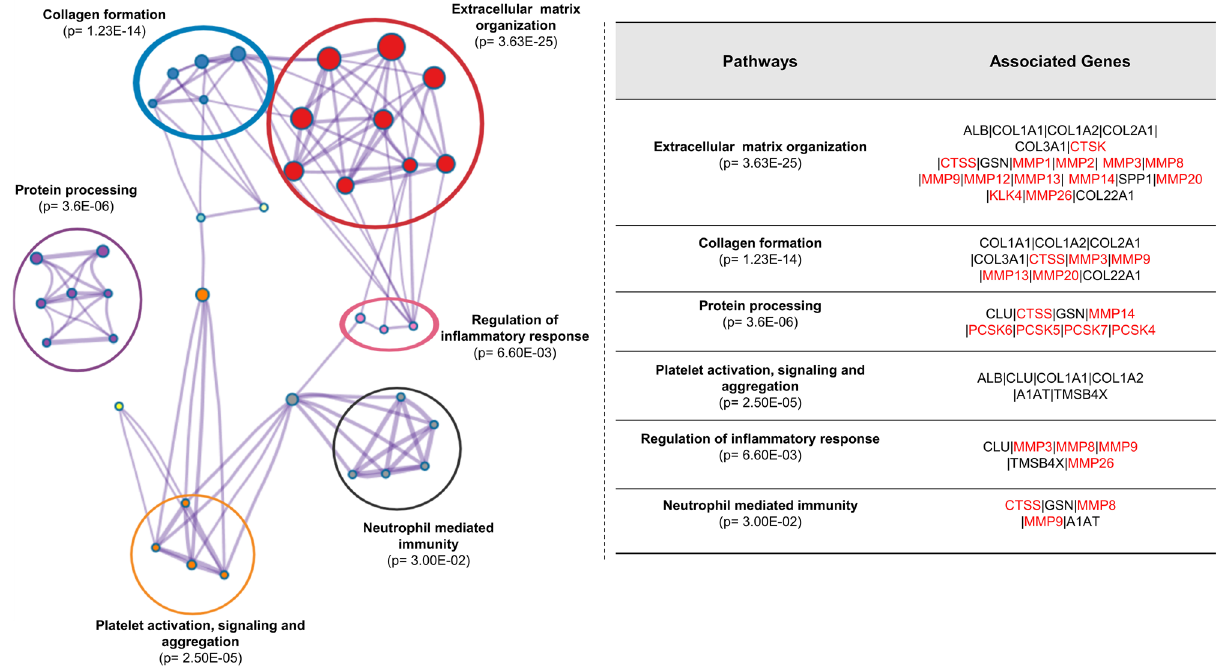
Figure 3. Pathway enrichment analysis. Pathway enrichment analysis of the 18 shortlisted proteases along with the 110 protein precursors of the differentially excreted peptides. The six most significant clusters are presented in different colours and the most significant term of each cluster was selected as label. For each term the corrected P-value along with the associated gene names are presented. The associated proteases are highlited in red